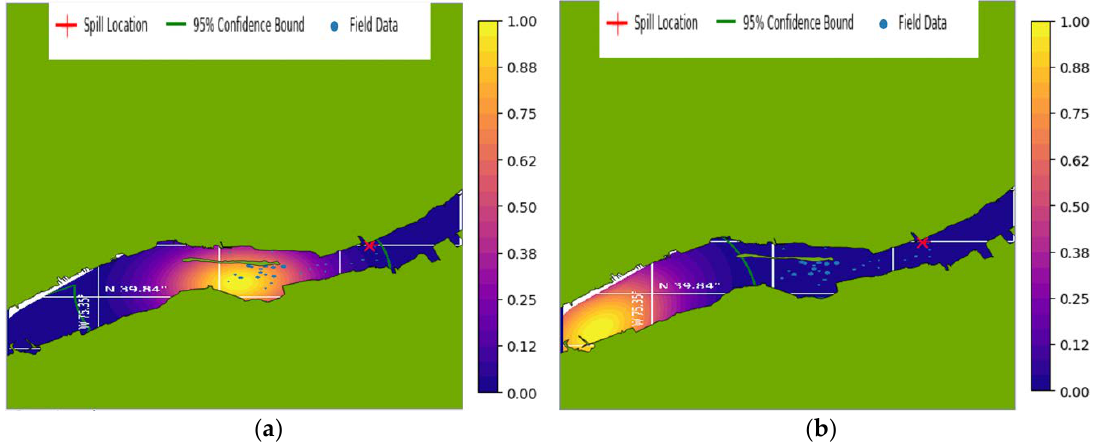
Figure 3. ( a ) SOSim’s relative probability of finding sunken oil on 8 December 2004, 12 days after the M/T Athos I spill; ( b ) SOSim’s relative probability of finding sunken oil on 20 December 2004, 24 days after the M/T Athos I spill. (Cardinal directions in image: North = top, South = bottom, East = right, West =